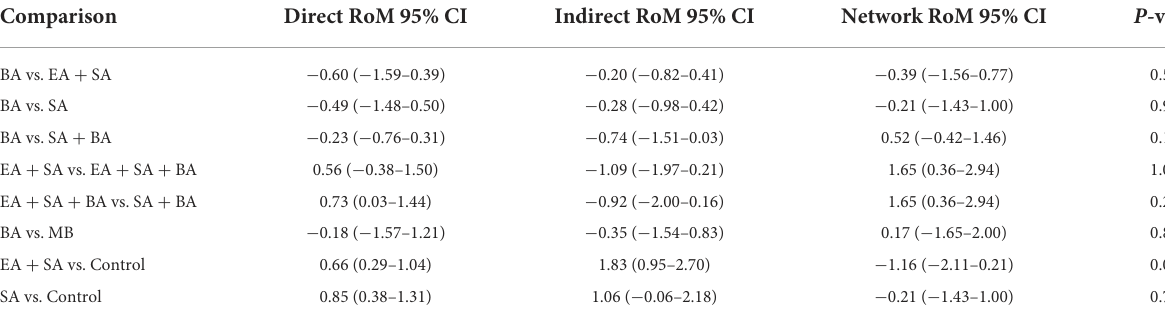
TABLE 3 Node-splitting analysis of inconsistency (cognitive function).